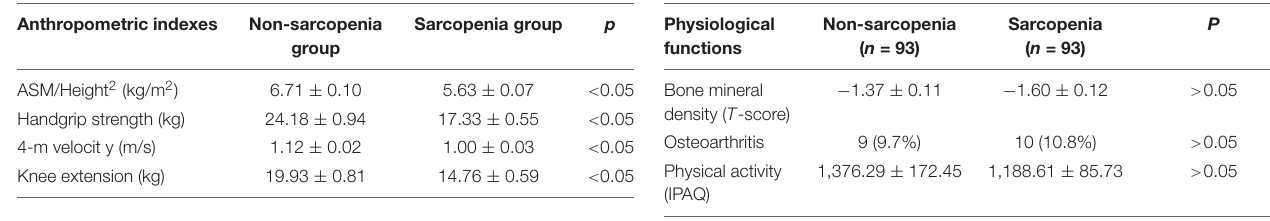
TABLE 2 | Anthropometric indexes of participants by sarcopenia status. TABLE 3 | Evaluated parameters in participants with